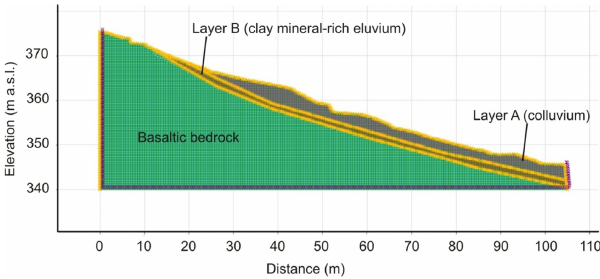
Figure 3. Carrè landslide cross section used in the numerical simu-